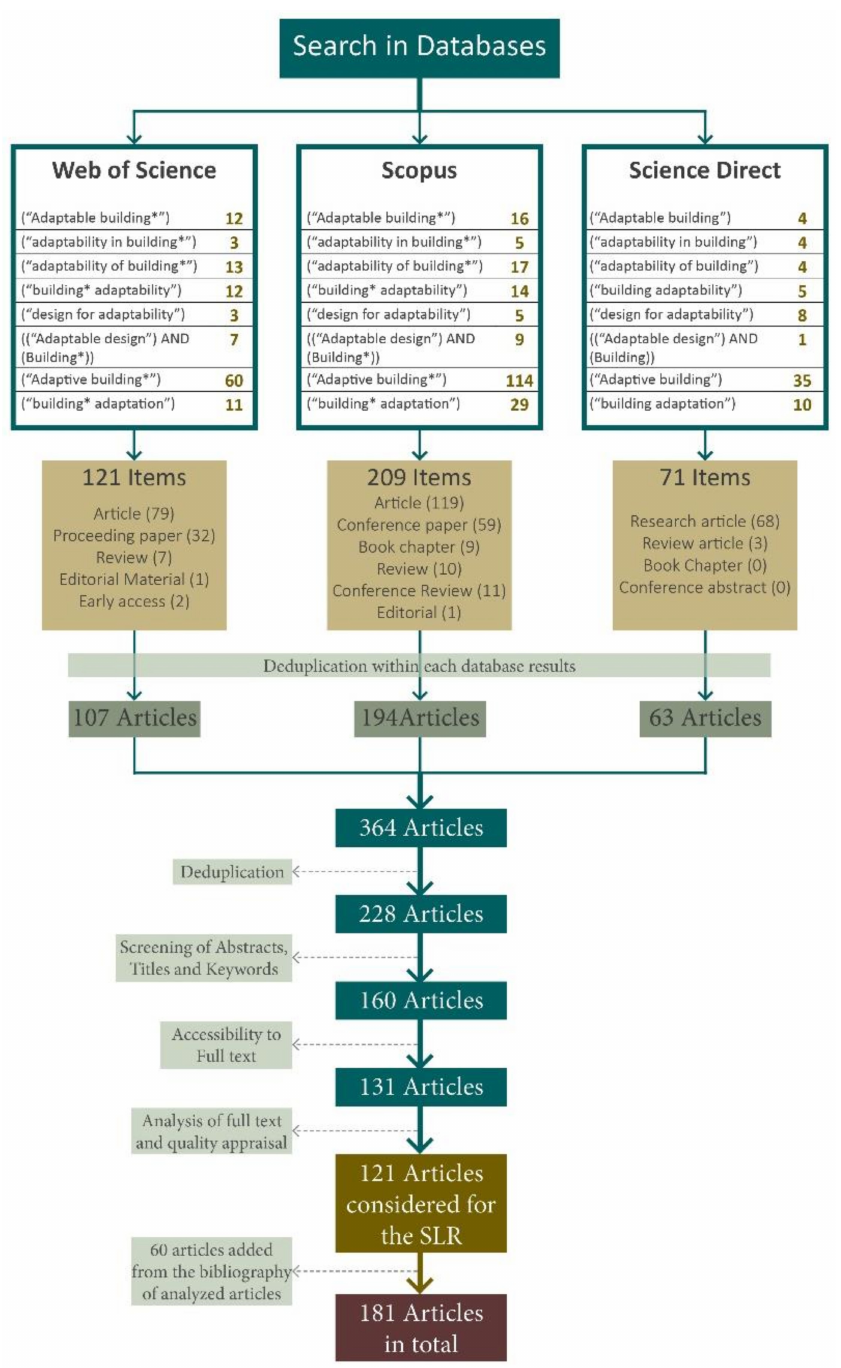
Figure 1. Results of database